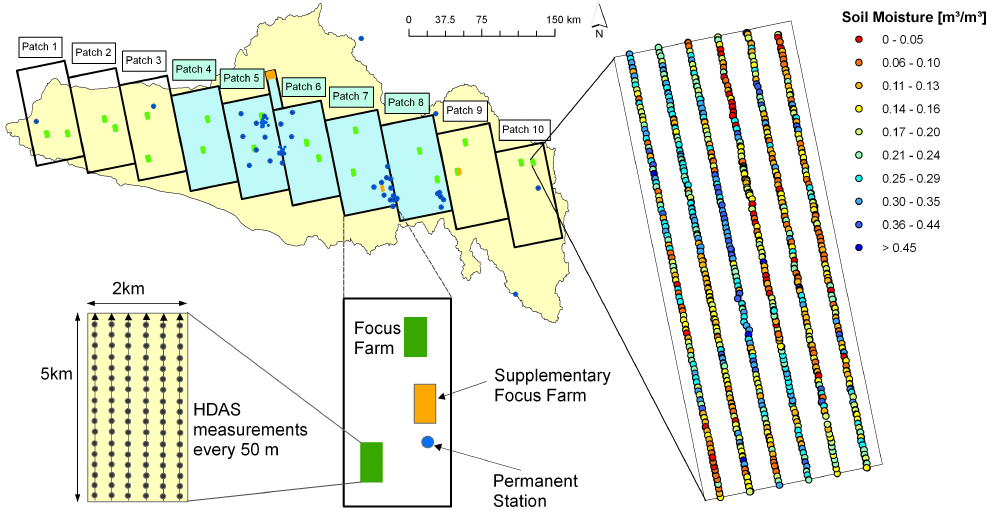
Fig. 5. Left panel: schematic of the ground sampling strategy concentrating on two focus farms per patch. Each focus farm was instrumented with two temporary monitoring stations and covered by six soil moisture sampling lines. Right panel: example of ground sampled, near-surface soil moisture data using the HDAS system.